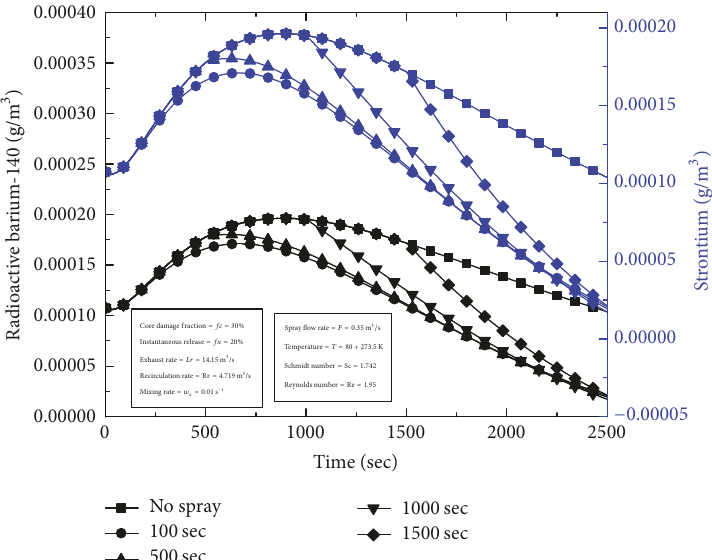
Figure 11:Responseof airbornebarium and strontiumwith spray activation timeduring in-vesselrelease phasewith mixing rate 𝑤 푥 = 0.01 s −1 .